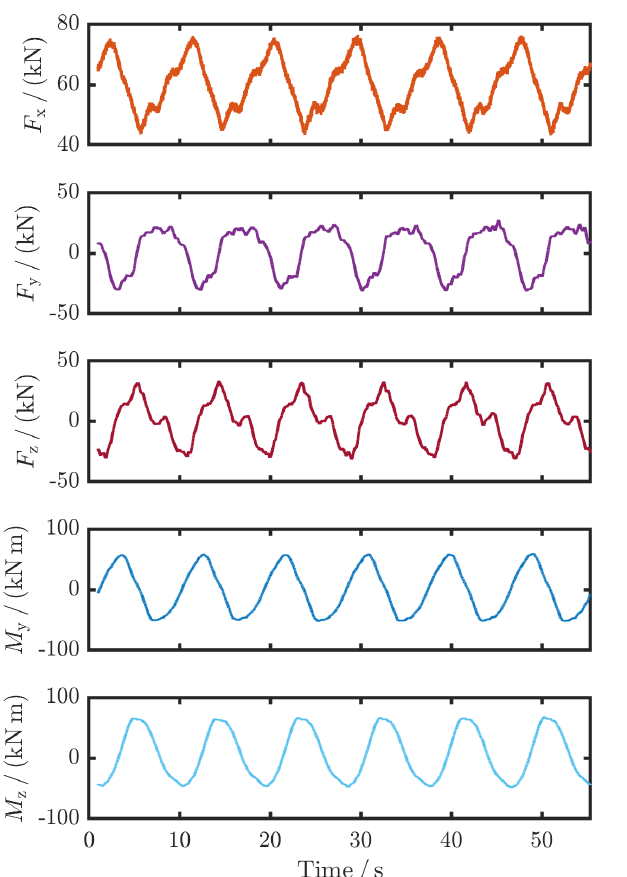
Figure 8. Additional multi-component loads during the calibration measurements due to the inaccuracy of the control system of the